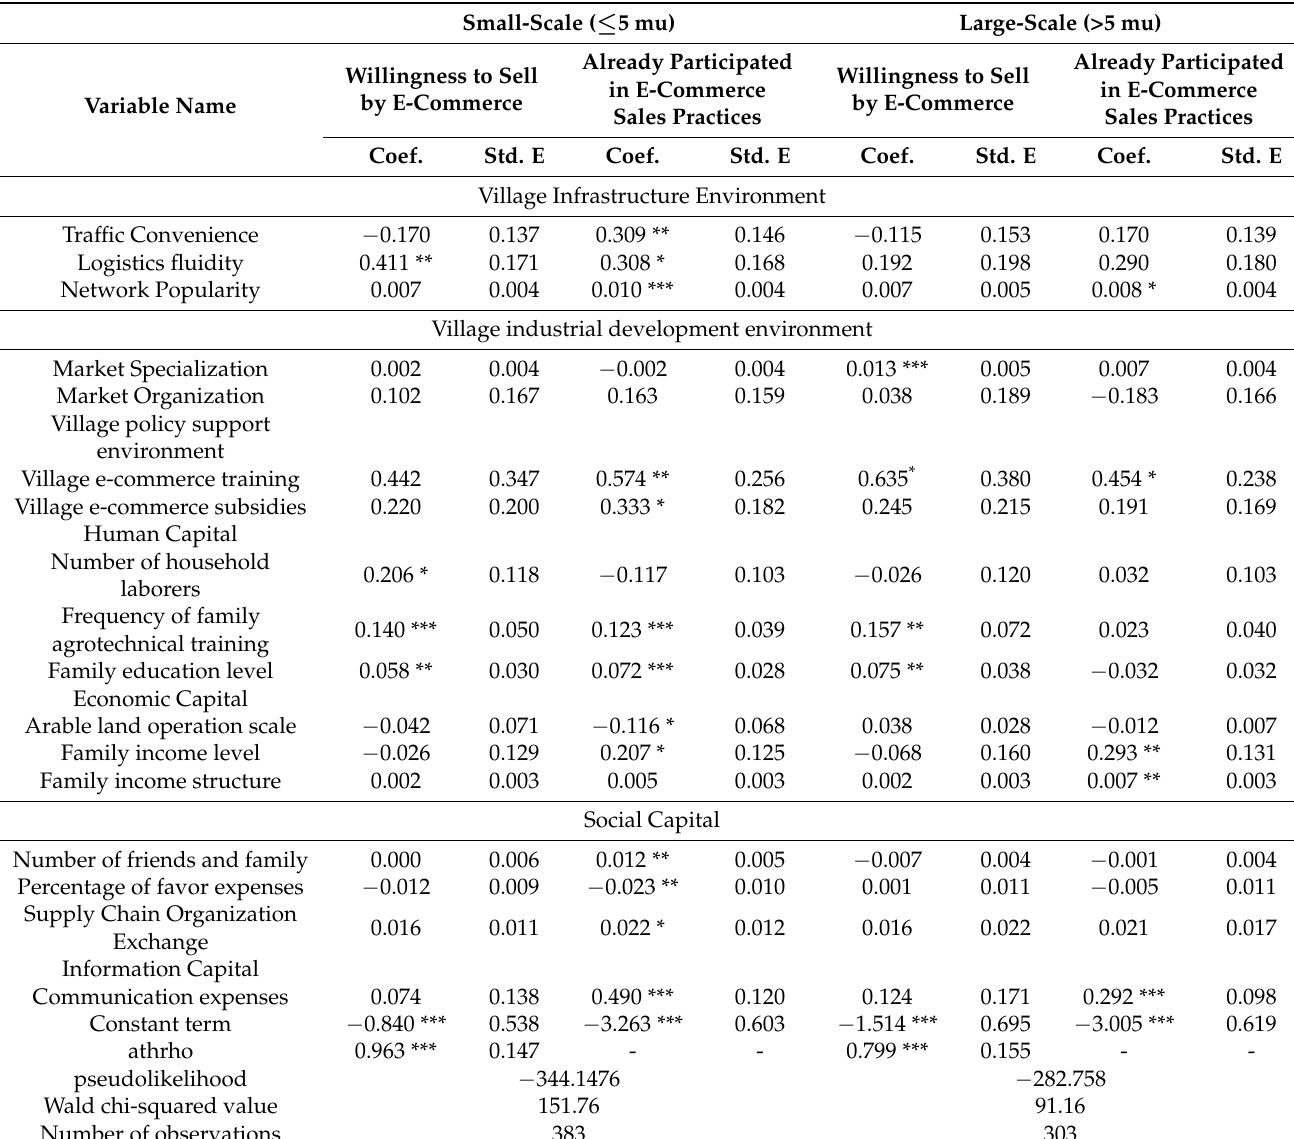
Table 4. The results of the impact of village environment and capital endowment on the e-commerce sales demand and behavior of different scale